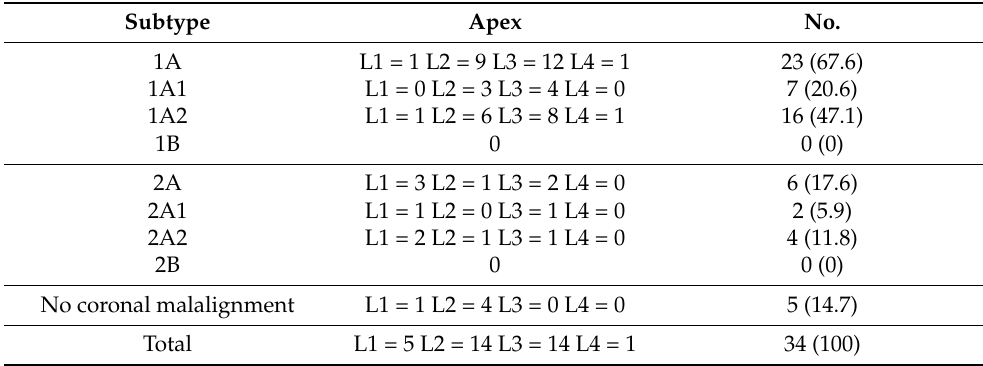
Table 1. The distribution of modifiers in the Type L according to Obeid-coronal. Malalignment subtype values are presented as number